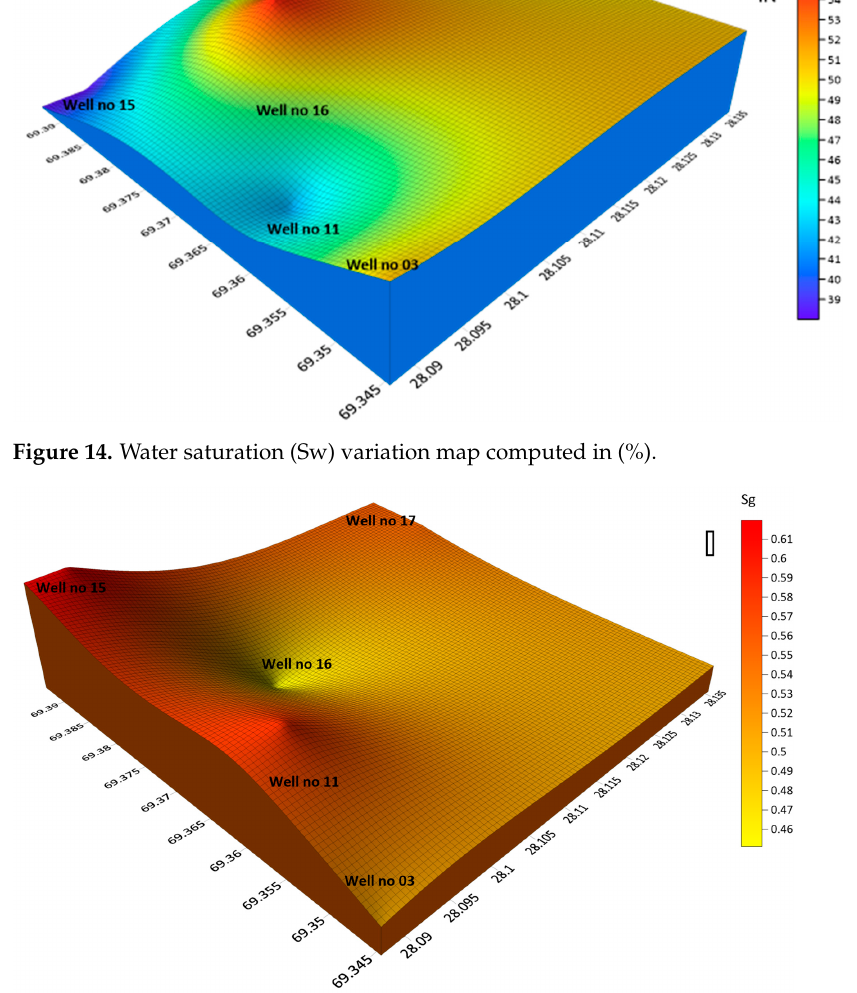
Figure 15. Gas saturation (Sg) variation map computed in (%).